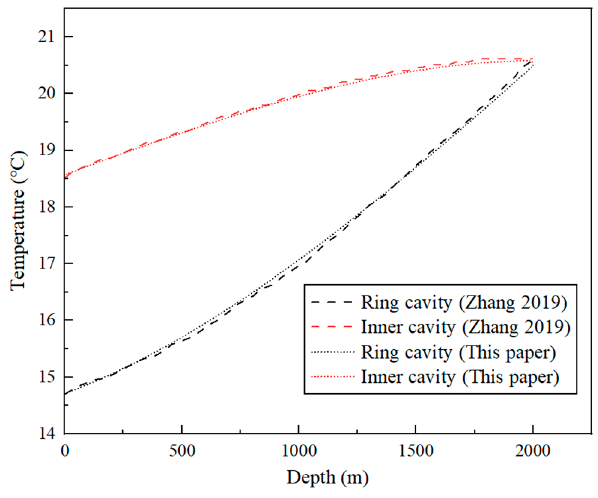
Figure 4. Model validation [3].